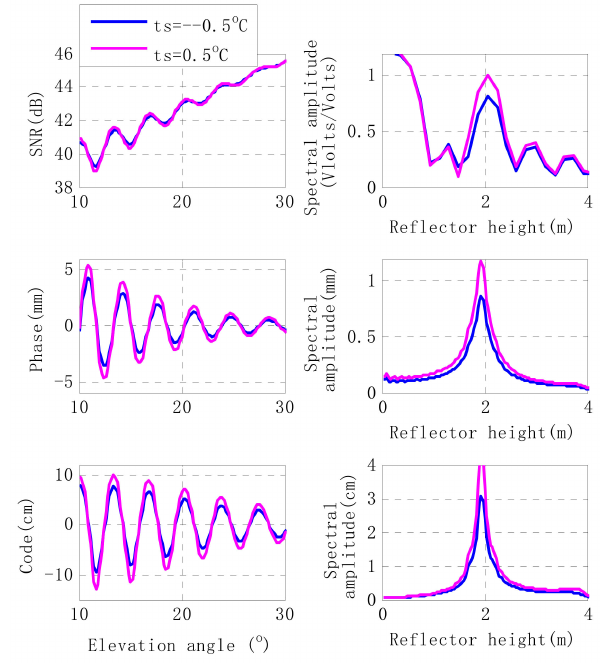
Figure 2. Soil temperature effects on GPS multipath observations (GPS SNR, carrier phase, and code pseudorange). Lomb–Scargle spectrogram analysis is presented in the right panel. Soil temperature with − 0.5 ◦ C is shown in blue, 0.5 ◦ C in